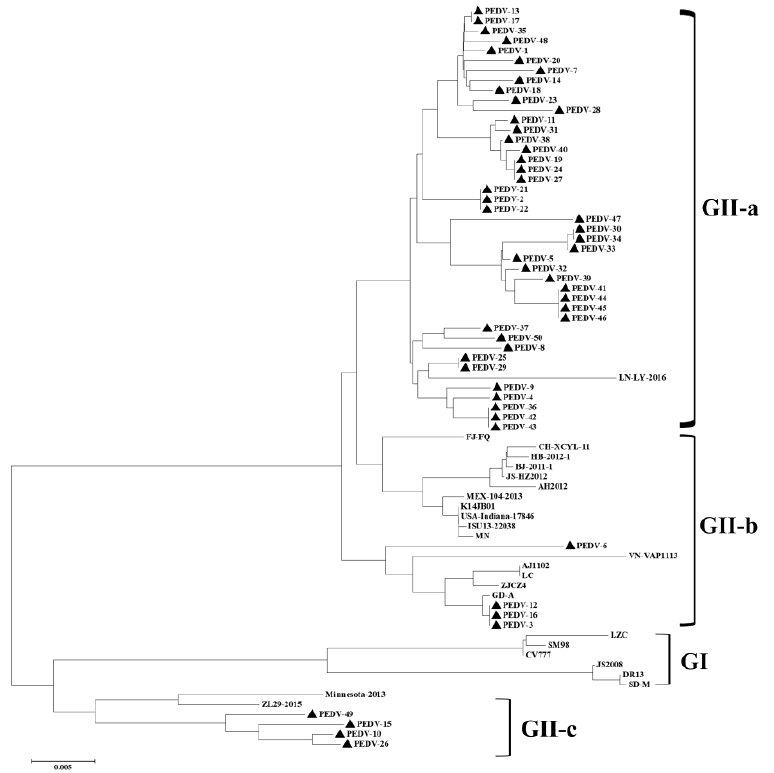
Figure 3. Phylogenetic analysis based on the PEDV S1 genes sequenced in this study. The phylo- genetic tree was generated by the neighbor-joining method in MEGAX software with a p-distance model, using 1000 bootstrap replicates. The triangles represent the strains isolated in this study, and those without triangles represent the reference strains.